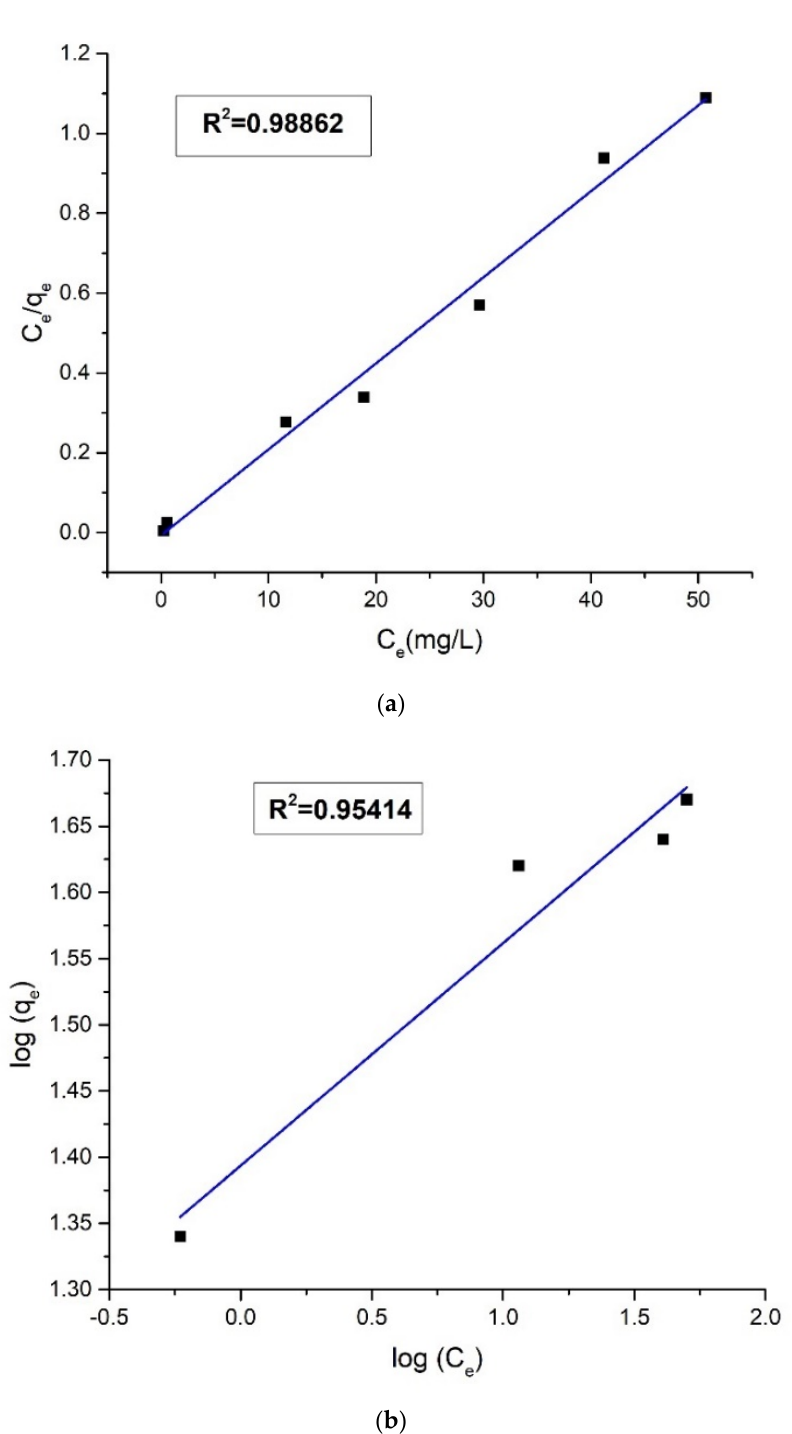
Figure 15. ( a ) Plot of Langmuir isotherm and ( b ) plot of Freundlich isotherm for the adsorption of Orange G.